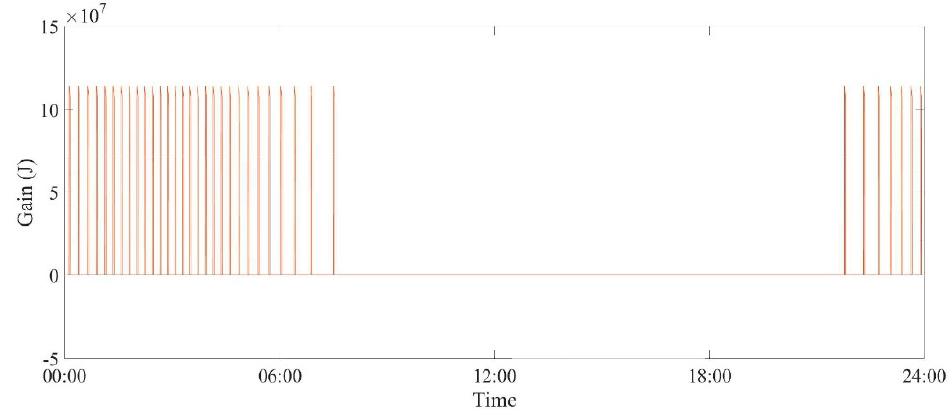
Figure 8. Energy use by On/Off at a normal condition.